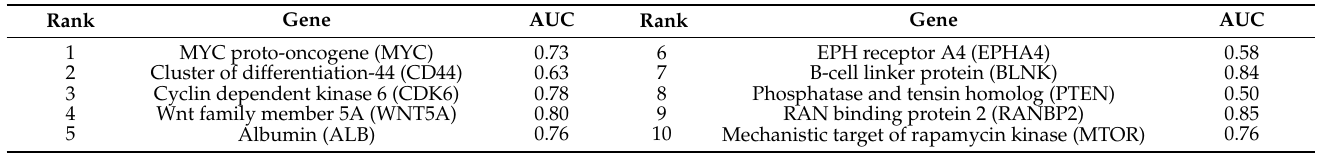
Table 1. The top 10 ranked genes and their AUC